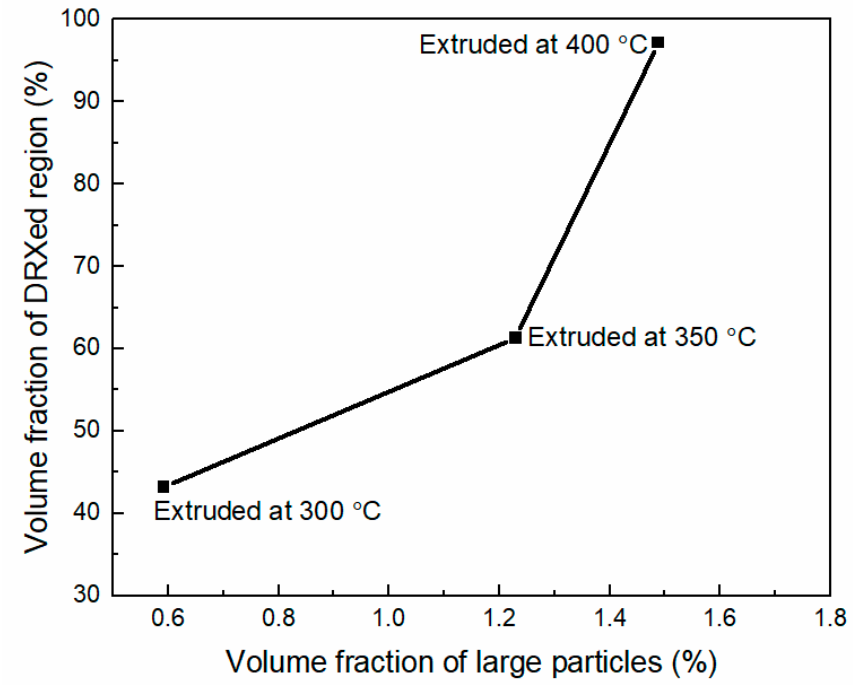
Figure 12. The relationship between volume fraction of the DRXed region and the volume fraction of large precipitates (>1 µm).